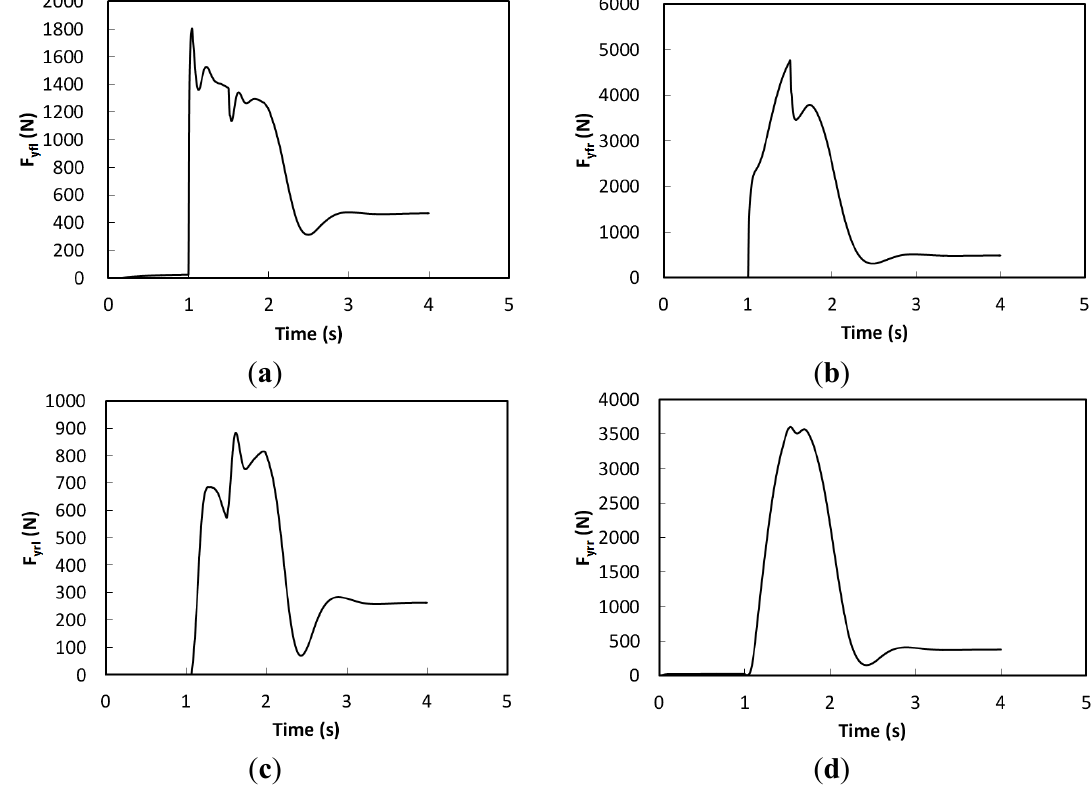
Figure 25. The lateral tire forces with upper level control. ( a ) Front left wheel; ( b ) Front right wheel; ( c ) Rear left wheel; ( d ) Rear right wheel.